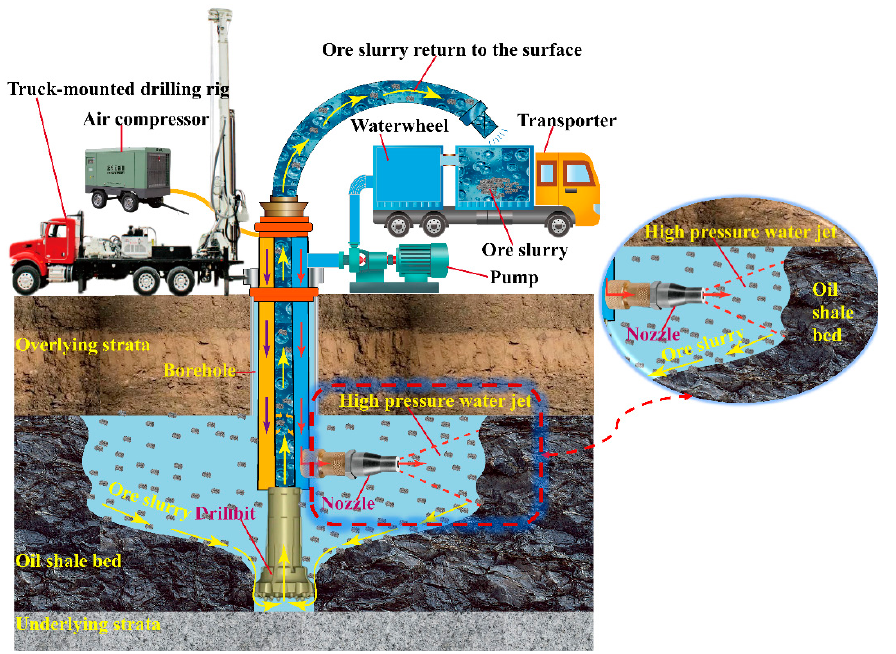
Figure 1. Borehole hydraulic mining schematic diagram.